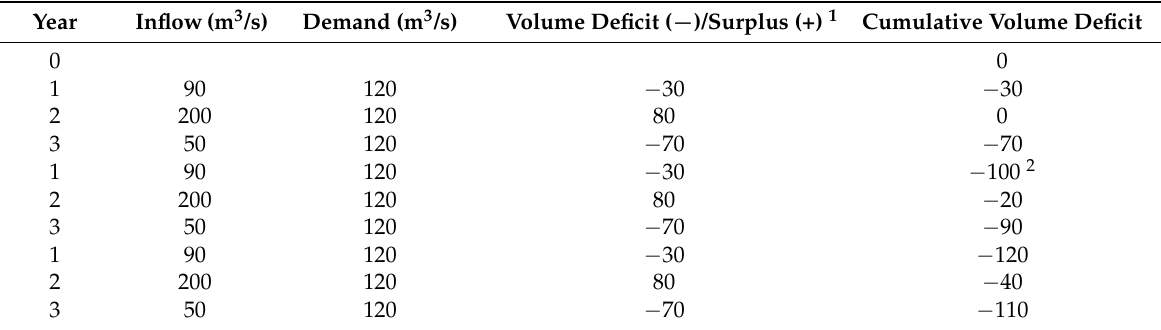
Table 3. Computation of storage capacity for V T <